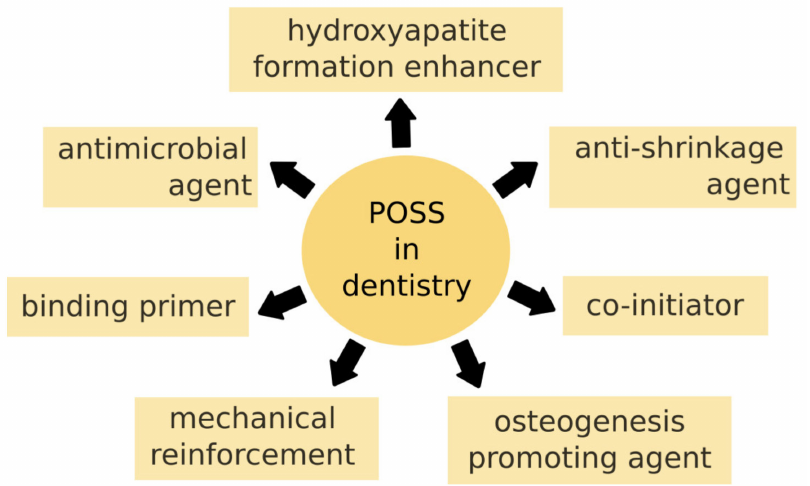
Figure 3. Application of POSS in